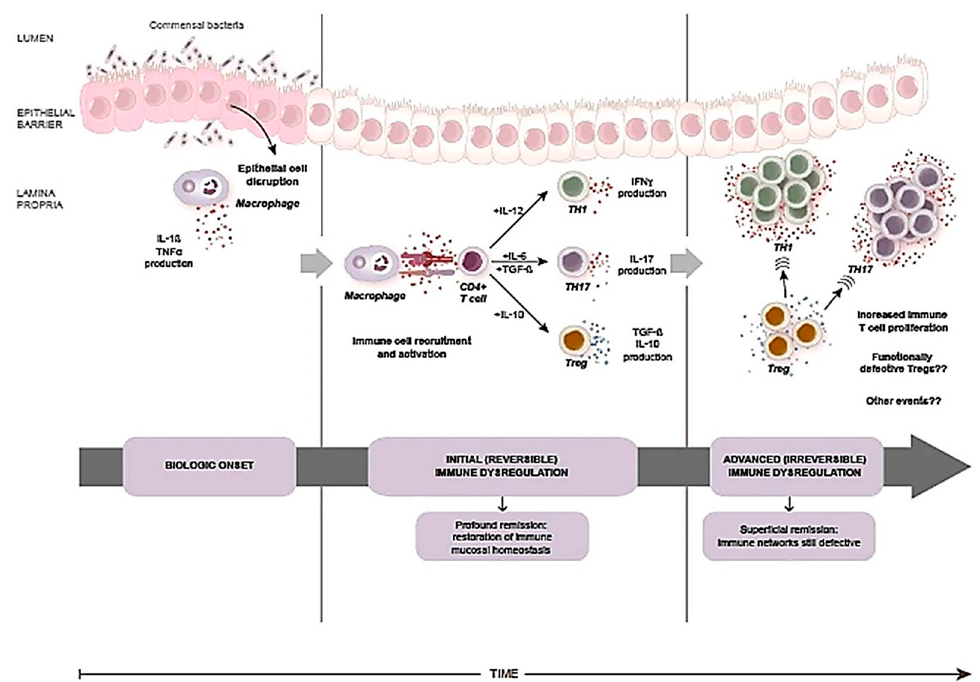
Figure 4. Biologic evolution and immunological events in Crohn’s disease. Unidentified environmental triggers might cause epithelial cell disruption and activate the innate immune system which leads to disease onset with cytokine production by macrophages and other cells. Immune cell recruitment and activation follows. It is possible that during these early disease stages dysfunctional immunoregulatory networks could be deeply restored by therapy. As the disease progresses mucosal homeostasis might become irreversibly altered. Initiating therapy at this stage might lead to superficial and transient disease remission and therapy must be continued. (Modified and reprinted with permission